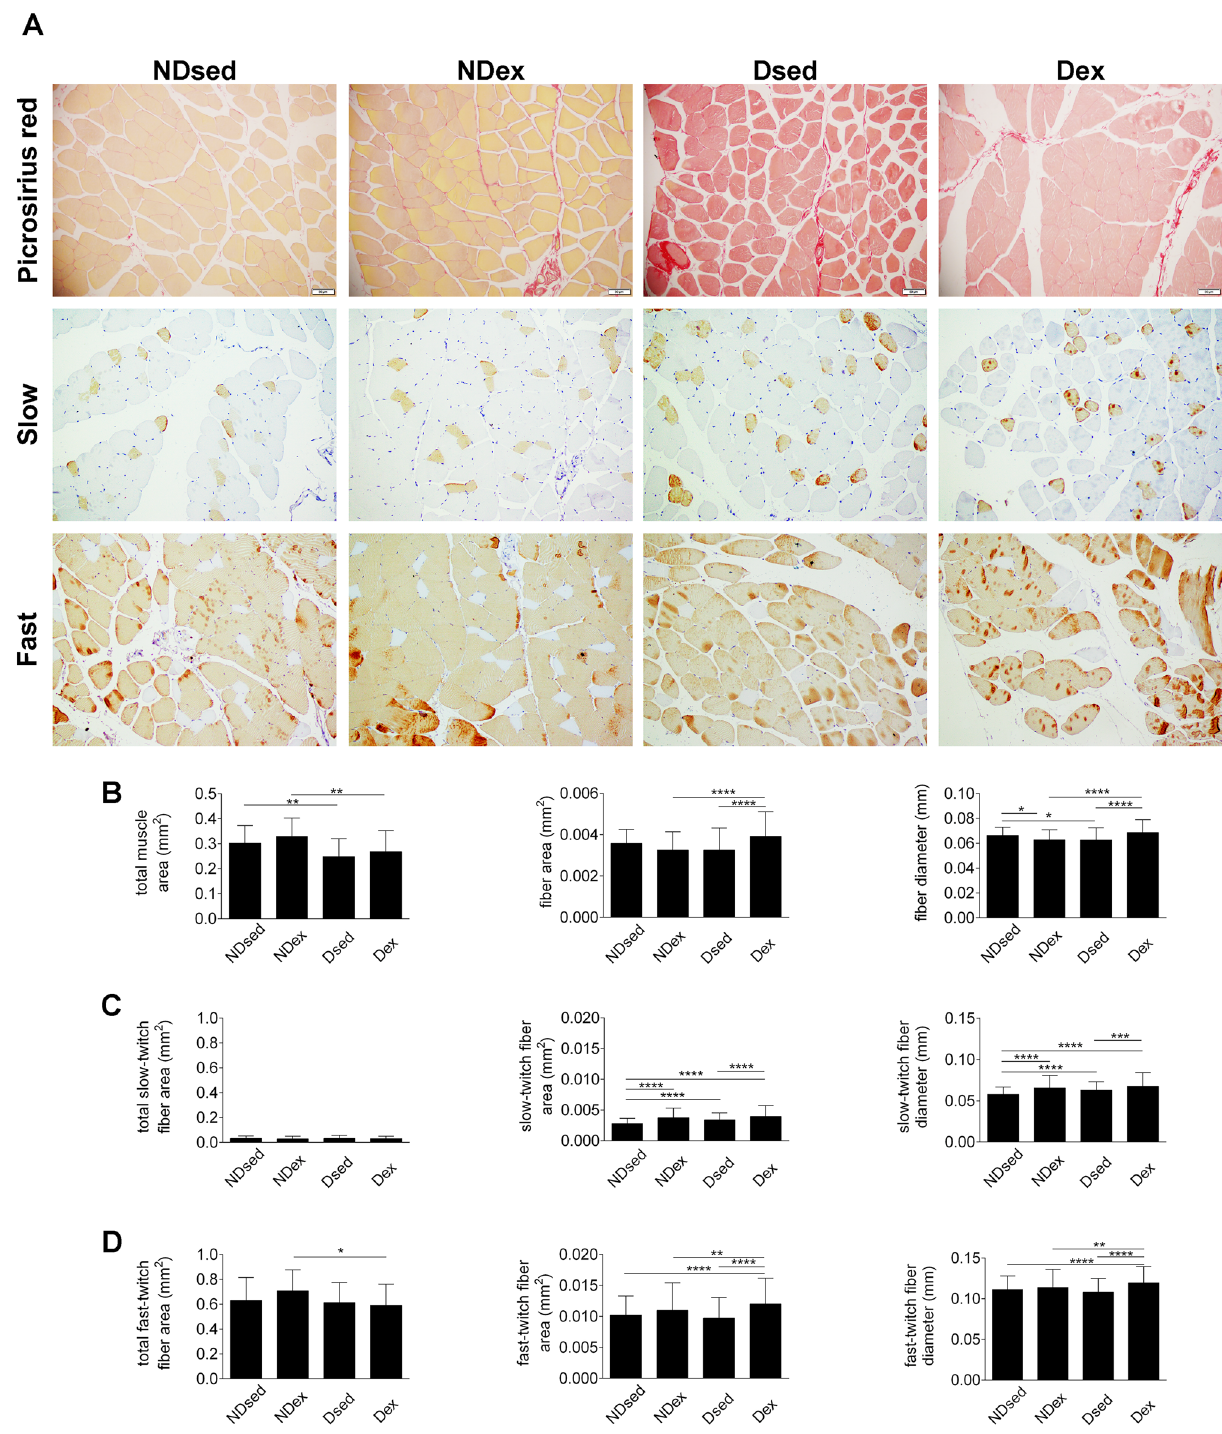
Figure 2. Histological sections of rat rectus abdominis muscle (RAM), obtained from CellSens Dimension (Olympus Corporation®) Version 1.16 image analysis software—(https:// www. olymp us- lifes cience. com/ en/ softw are/ cells ens/). (A ) RAM samples were taken from non-diabetic sedentary (NDsed), non-diabetic exercised (NDex), diabetic sedentary (Dsed) and diabetic exercised (Dex) rats as described in “Materials and methods”. RAM samples were stained with picrosirius red and immunohistochemistry against myosin heavy chain of slow and fast RAM fibers. (B) Picrosirius red staining for total muscle area, fiber area, and fiber diameter in RAM samples as in ( A ). ( C ) Immunohistochemistry for total slow-twitch fiber area,slow-twitch fiber area, and slow-twitch fiber diameter as in ( A ). ( D ) Immunohistochemistry for total fast-twitch fiber area,fast-twitch fiber area, and fast-twitch fiber diameter as in ( A ). Values are means ± S.D. (n = 5 animals/group. *p < 0.05, **p < 0.01, ***p < 0.001 and ****p < 0.0001. Scale bar: 50 µm. Magnification: